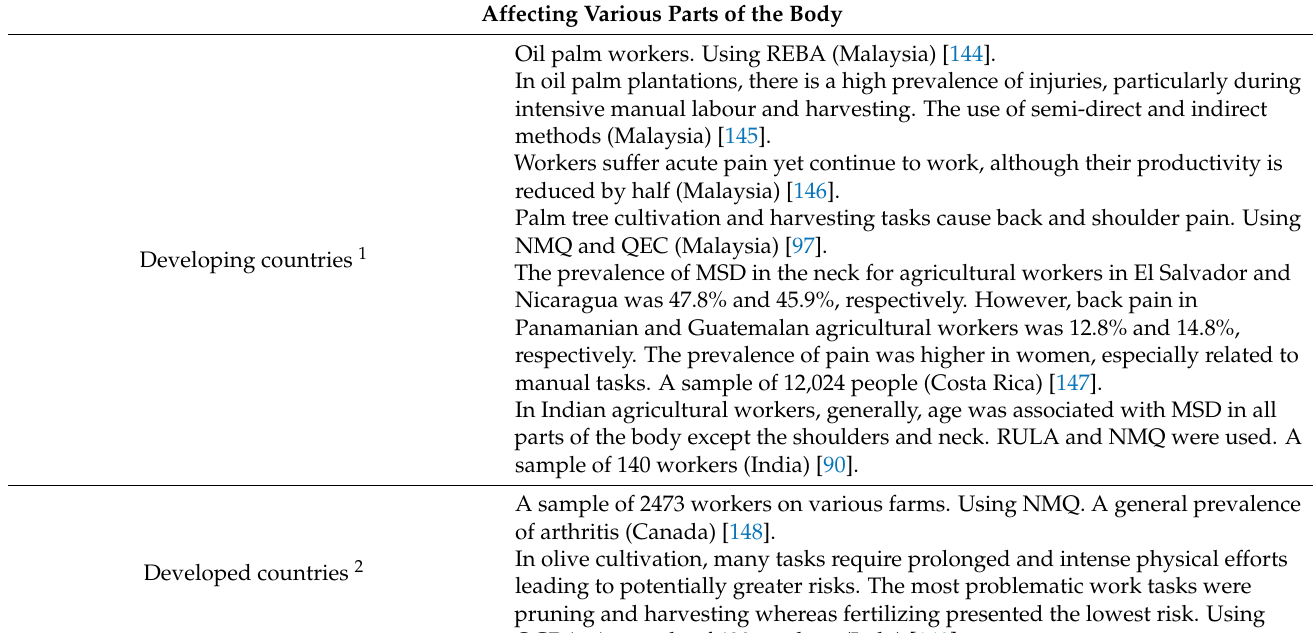
Developing countries